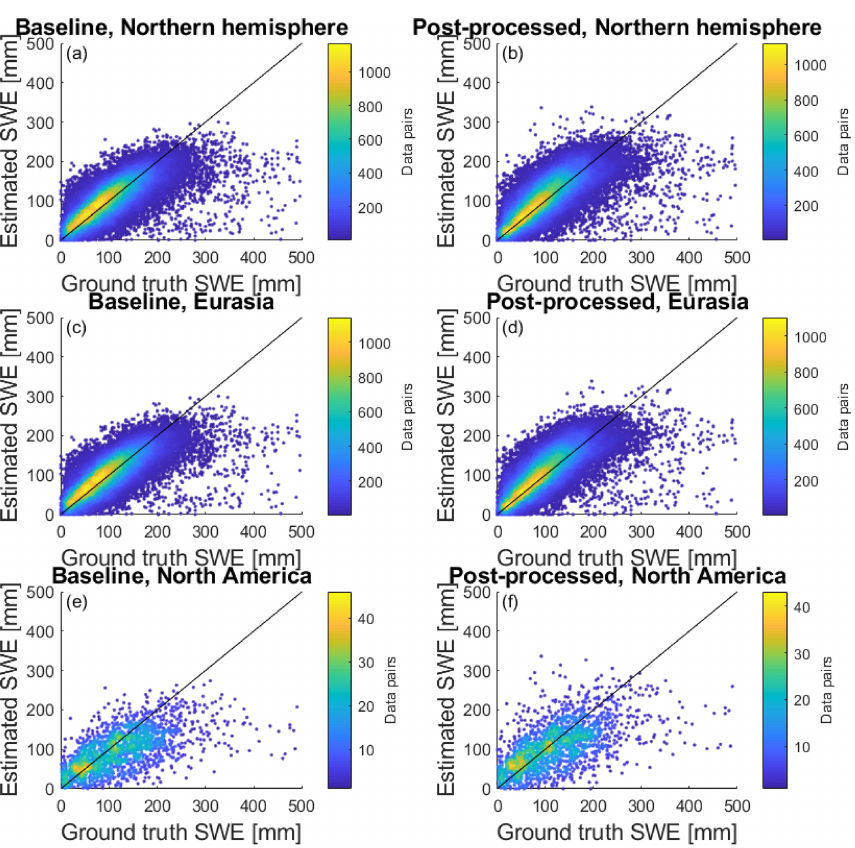
Figure 8. Density scatterplots of GSv3.0 baseline and post-processed retrieval accuracy for 1979–2018 for the whole Northern Hemisphere, Eurasia, and North